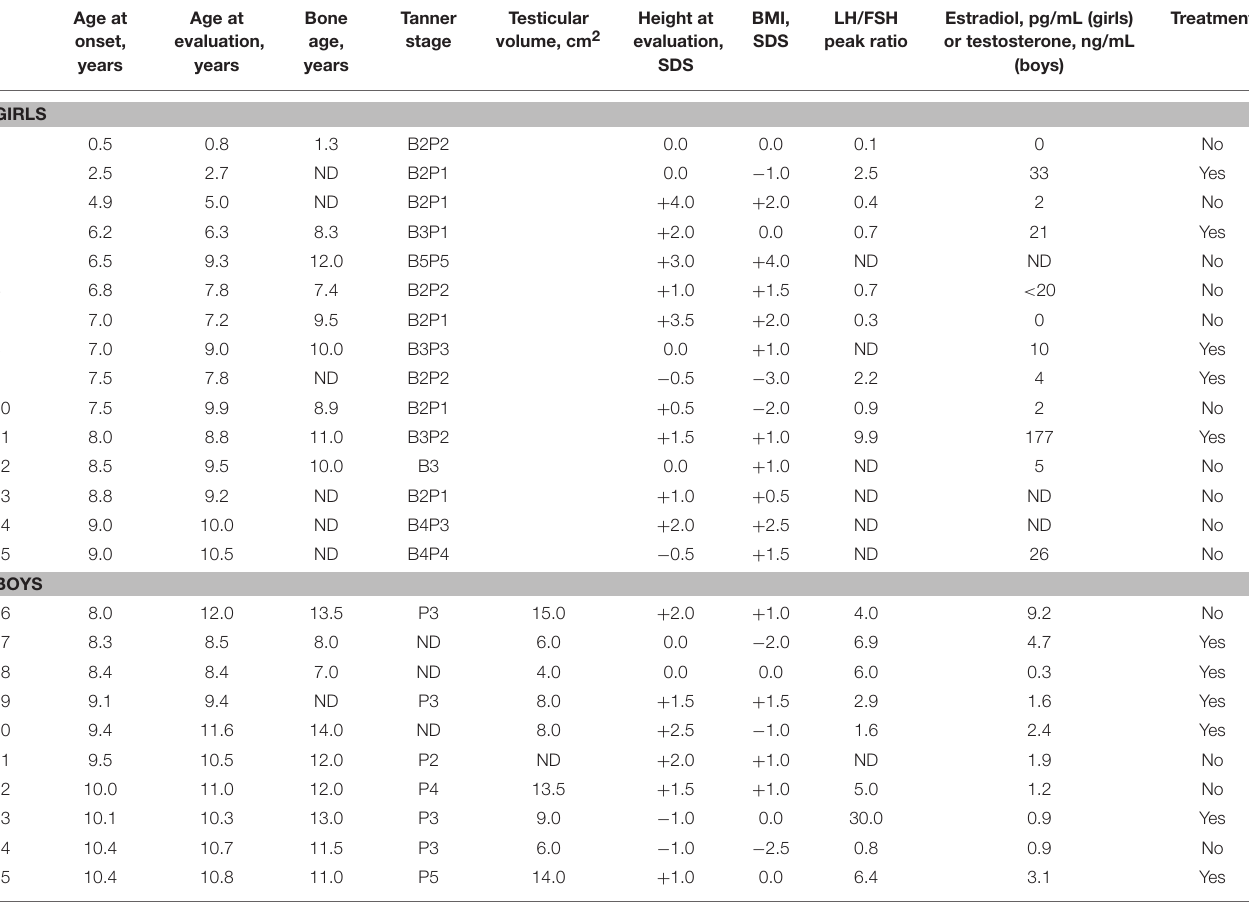
TABLE 1 | Characteristics of the patients with precocious or early puberty associated with other disorders. Age at